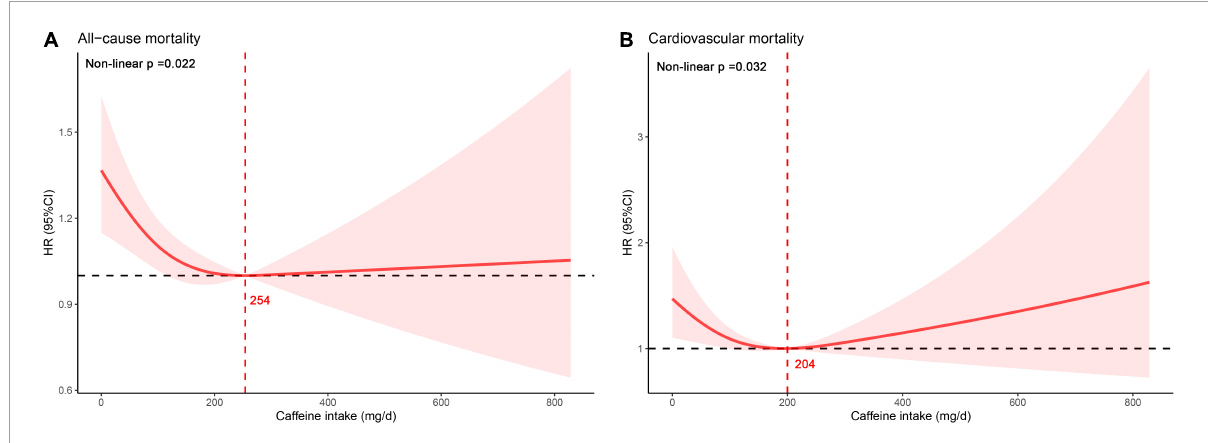
FIGURE4 Non-linear relationship between caffeine intake and mortality. (A) All-cause mortality. (B) Cardiovascular mortality.